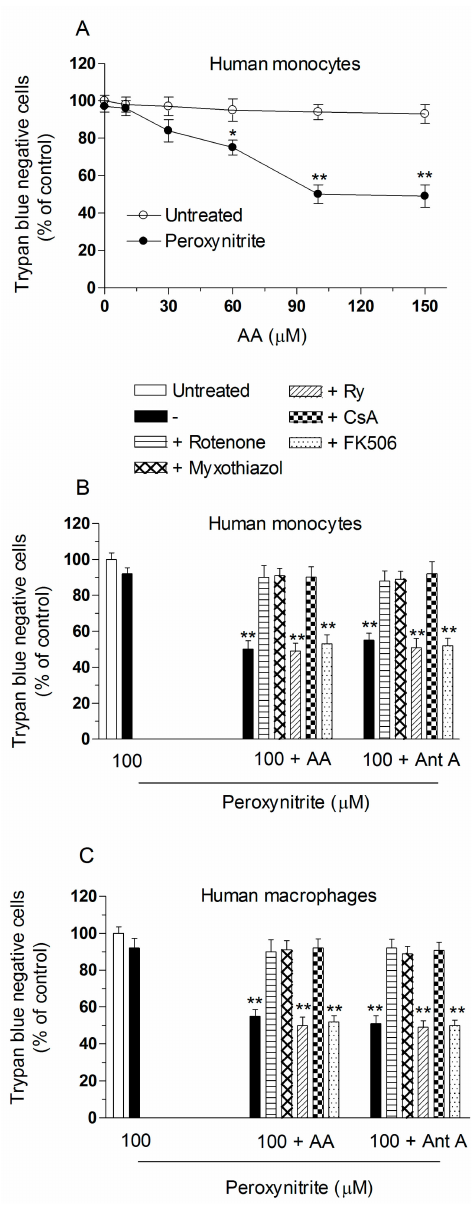
Figure 4. AA enhances the lethal response mediated by peroxynitrite in human monocytes or macrophages via a mechanism uniquely sensitive to rotenone, myxothiazol, or CsA. ( A ) Human monocytes were pre-exposed for 15 min to increasing concentrations of AA and then treated for a further 60 min with 0 or 100 µ M peroxynitrite. After treatments, the cells were analyzed for toxicity with the trypan blue exclusion assay. Results represent the means ± SD calculated from at least three separate experiments from three different donors. * p < 0.01 or ** p < 0.001 as compared to untreated cells (two-way ANOVA followed by Bonferron’s test). Human monocytes ( B ); and macrophages ( C ) were treated as shown in the figure and then exposed for 60 min to peroxynitrite. After treatments, the cells were analyzed for toxicity with the trypan blue exclusion assay. Results represent the means ± SD calculated from at least three separate experiments using monocytes (or monocyte-derived macrophages) from three different donors. ** p < 0.001 as compared to untreated cells (one-way ANOVA followed by Dunnett’s